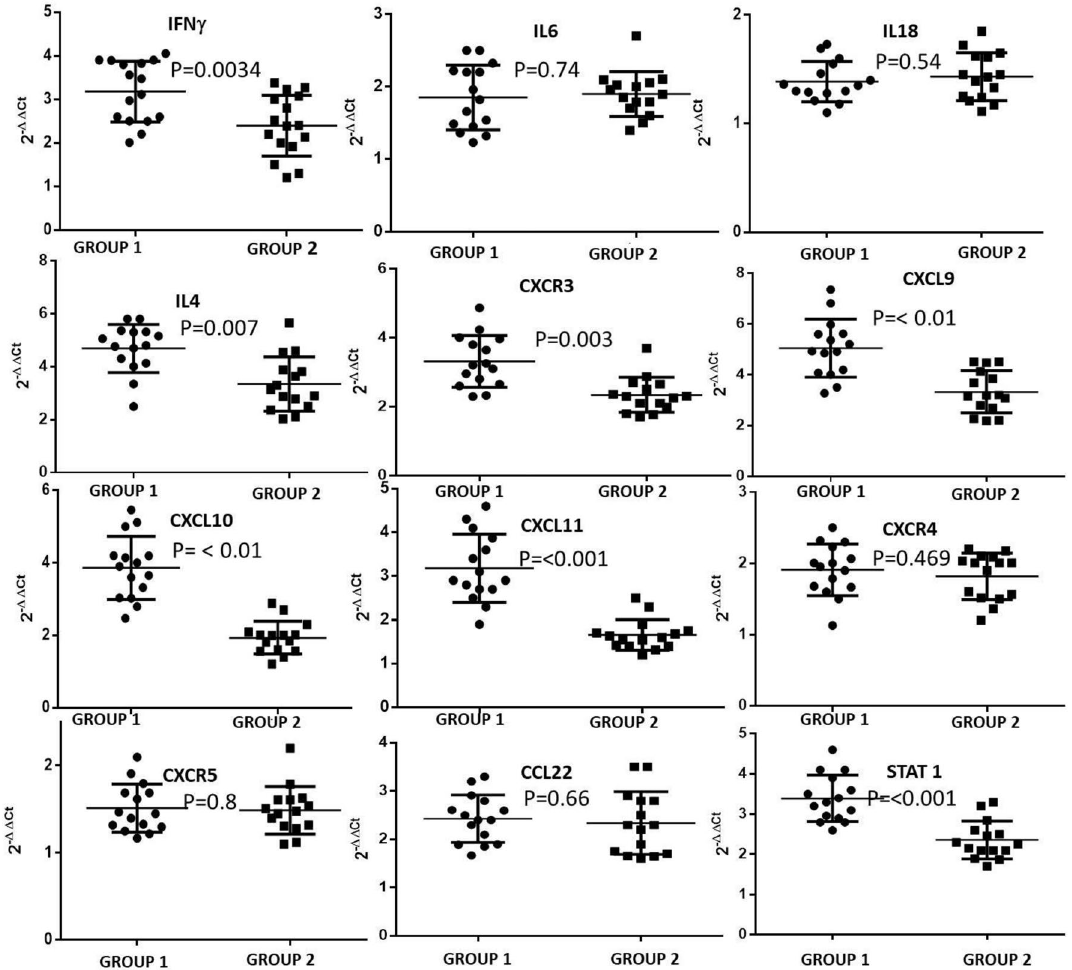
Figure 2. Differential mRNA expression of some selected chemokines and cytokines from patients belonging to the two different groups (N = 15). Their relative mRNA expression ratio with respect to group 3 control group (Baseline expression) in terms of fold change (2 −ΔΔCt ) were estimated by quantitative real time PCR. GAPDH mRNA served as internal control (+ 1 value in Y axis was considered to be the baseline of control, with values greater than 1 suggesting positive fold change and values below 1 upto 0 as negative fold